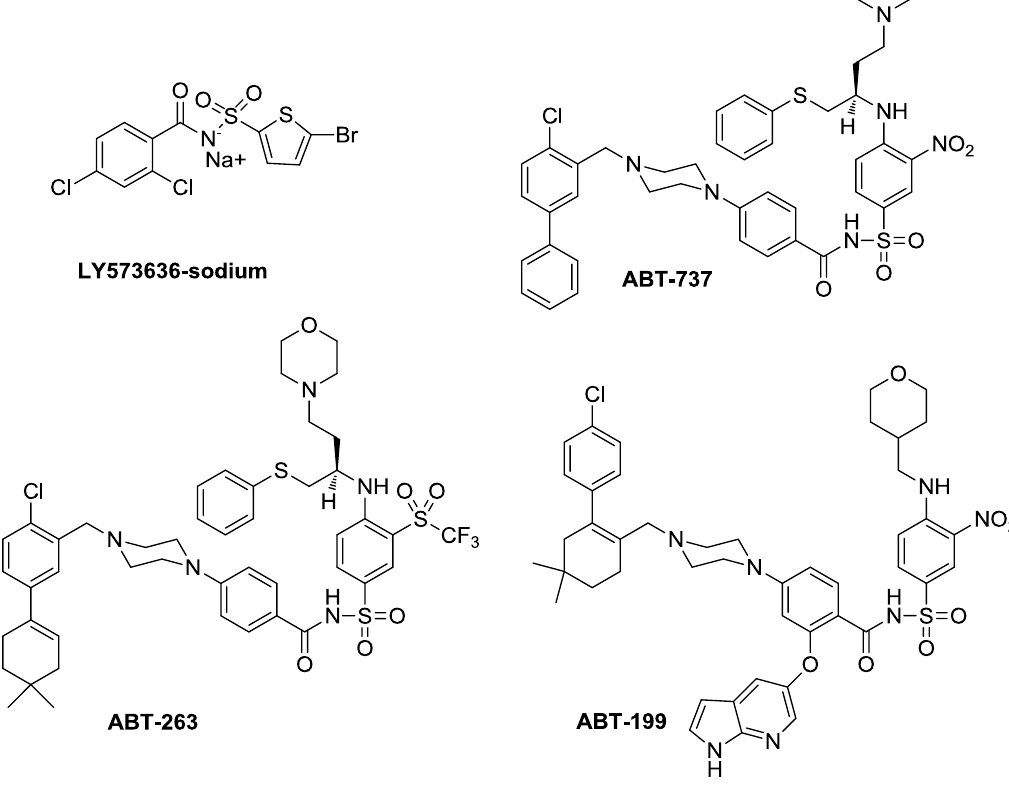
Figure 1. Clinically evaluated antitumor N -acylsulfonamides: LY573636-sodium (Tasisulam